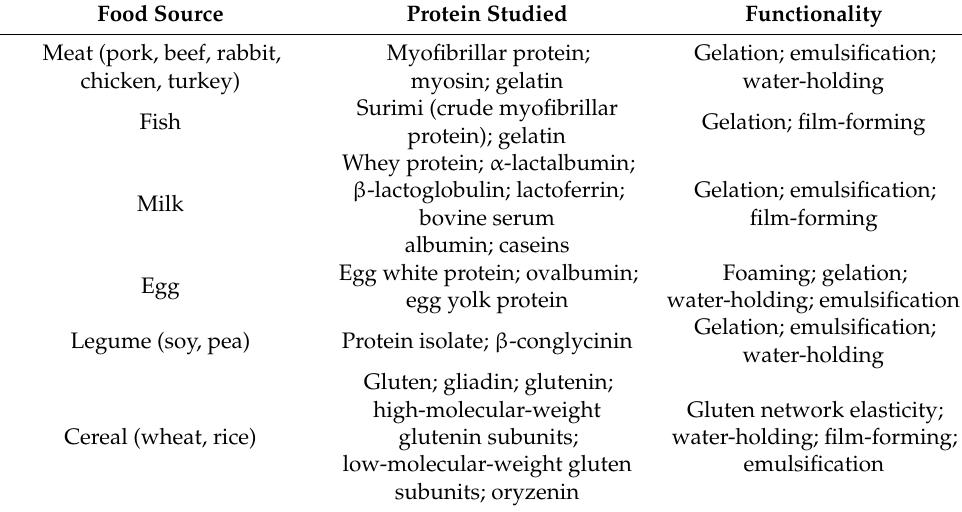
Table 1. Examples of proteins from different sources that have been subjected to oxidation